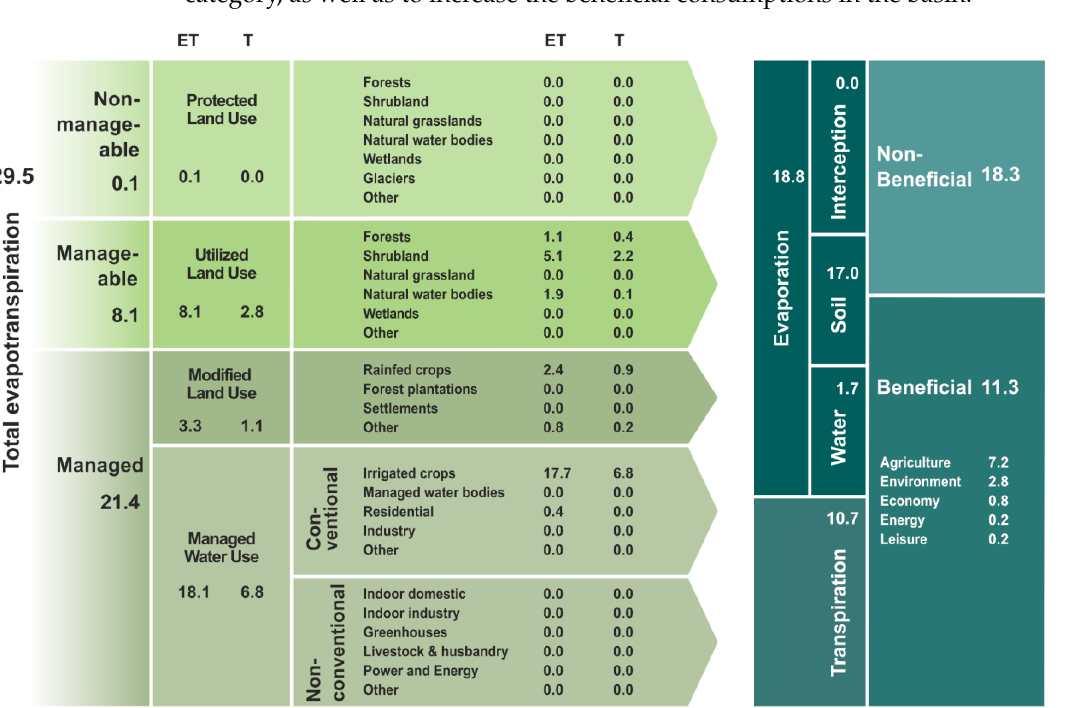
Figure 13. Sheet 2 was generated using WA+, with details of total water consumption in the basin for PERSIANN precipitation datasets, based on wet year (2016–2017).